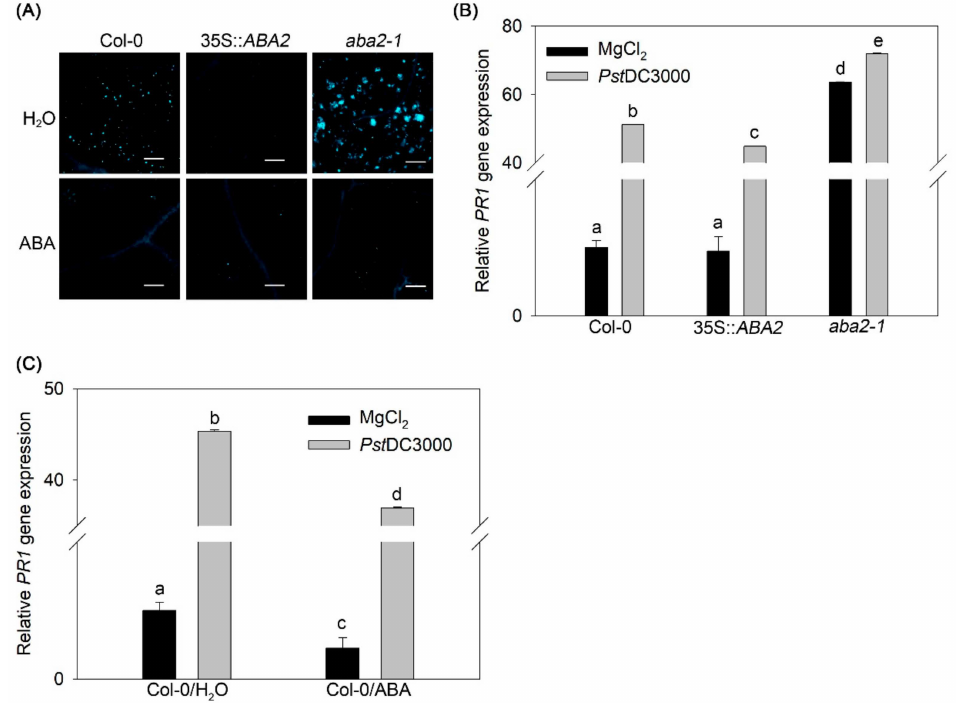
Figure 5. E ff ects of endogenous and exogenous abscisic acid (ABA) on callose formation and SA-dependent defense signaling in Arabidopsis . ( A ) Callose deposition and ( B ) and ( C ) PR1 expression. Wild-type (Col-0), the ABA2 transgenic line 35S:: ABA2 , and the ABA2 gene mutant aba2-1 were treated with distilled water (H 2 O) or ABA before inoculation with flg22 for detecting callose formation, and before inoculation with Pst DC3000 for detecting the expression of SA-dependent marker gene PR1 . Scale Bars = 200 µ m. Blue fluorescence means enhanced callose accumulation stained with Aniline blue. Error bars indicate the standard error, and values were based on at least three independent